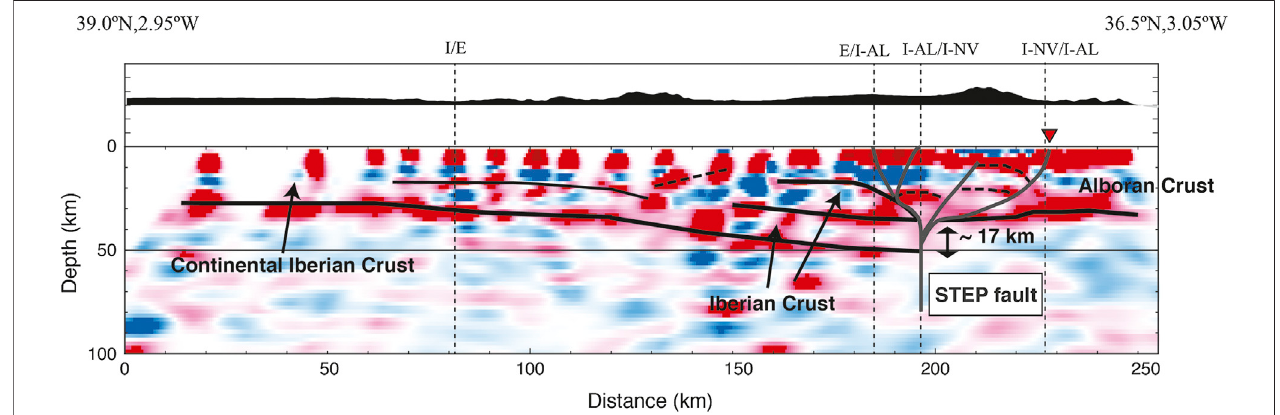
FIGURE3| MigratedCommonconversionpointimagesusingP-wavereceiverfunctionsofthehighdensitypro fi leHIRE(trianglesin Figure1A )probingthecrustal structure in central Betics. We overlap the images with our interpretations along the section: The crust-mantle boundary (Iberian and Alboran Moho, thick black lines), intracrustal converters (thin and dashed black lines) and the Subduction-Transform Edge Propagator fault and its continuation toward the surface as positive fl ower structure (gray lines). This image is a modi fi cation of the one published in Mancilla et al. (2018). For the details about the image construction and receiver function calculation see the source